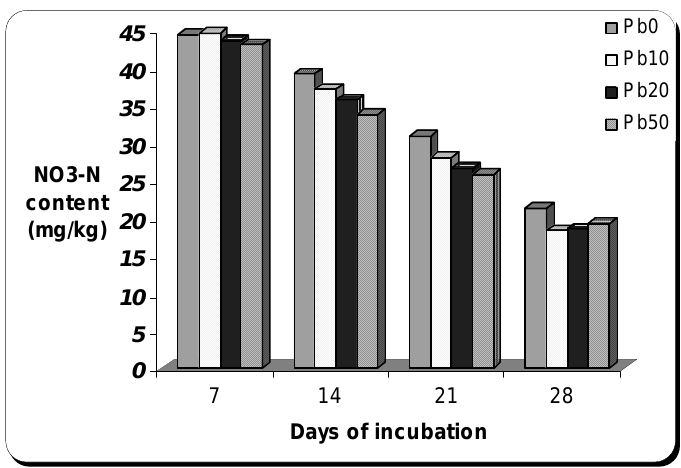
FIGURE 7 . Mean effect of different levels of Pb on the changes in NO 3 -N content under saturated soil.